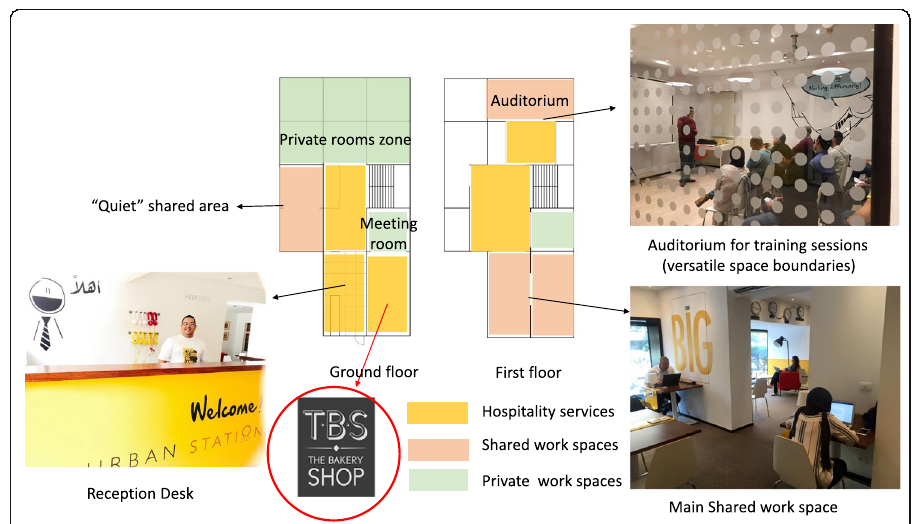
Fig. 11 More hospitality services for the open work environment of the second wave of co-working spaces; integrating of coffee shops within the co-working spaces of the second wave: Urban station co-working space, elaboration by